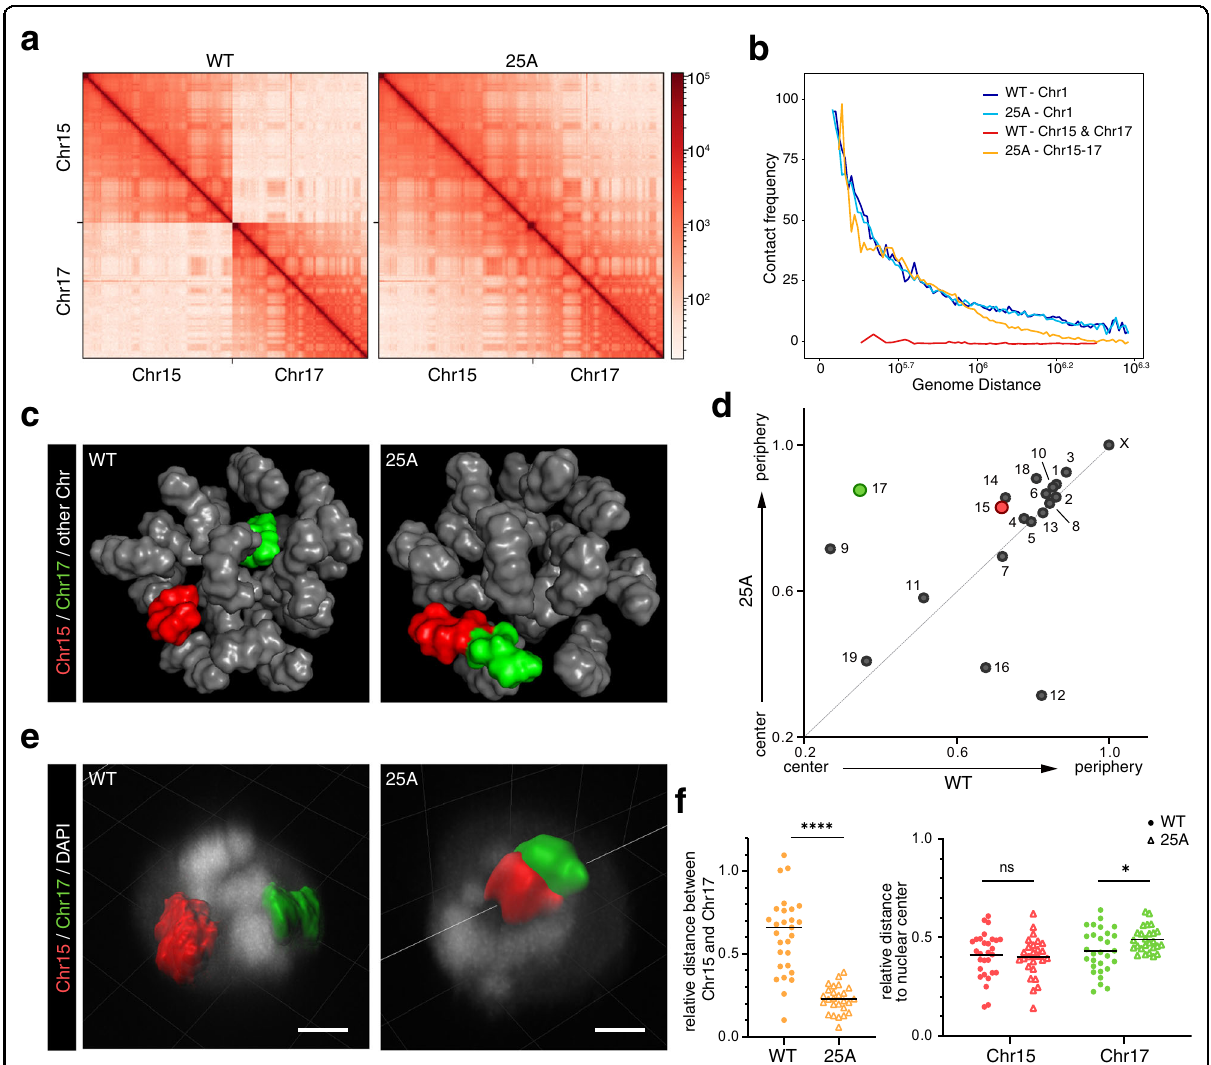
Fig. 2 Change of chromosome territory after Chr15 and Chr17 fusion. a Contact matrixes at 1 Mb resolution on Chr15 and Chr17 of WT and 25A cells. b Contact frequency curves showing contact probabilities as a function of genomic distances around fusion site (within 1 Mb) on Chr15 and Chr17. Chr1 was included as a single chromosome control. c Inferred 3D genome structures in WT and 25A cells using Hi-C data. Chr15 was shown in red and Chr17 in green. d Radial distributions of each chromosome relative to nucleus center in WT (horizontal axis) and 25A (vertical axis) derived from inferred 3D models ( c ). e 3D-FISH reconstruction of the Chr15 and Chr17 in WT and 25A haESCs. Chr15 was labeled in red and Chr17 in green. Scale bar: 2 μ m. f Quanti fi cation of relative distance between Chr15 and Chr17 (left), and relative distance of Chr15 and Chr17 to the nucleus center (right) in WT and 25A haESCs. (mean± SD, two-tailed ratio Student ’ s t -test, * P < 0.05, ** P < 0.01, *** P < 0.005, **** P < 0.0001, ns not signi fi cant. n = 29 and 26 cells,